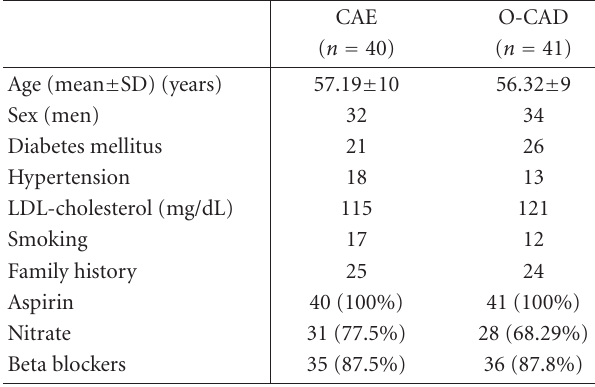
Table 1: Baseline clinical characteristics of the patients. CAE de- notes coronary ectasia and O-CAD denotes obstructive coronary artery disease.